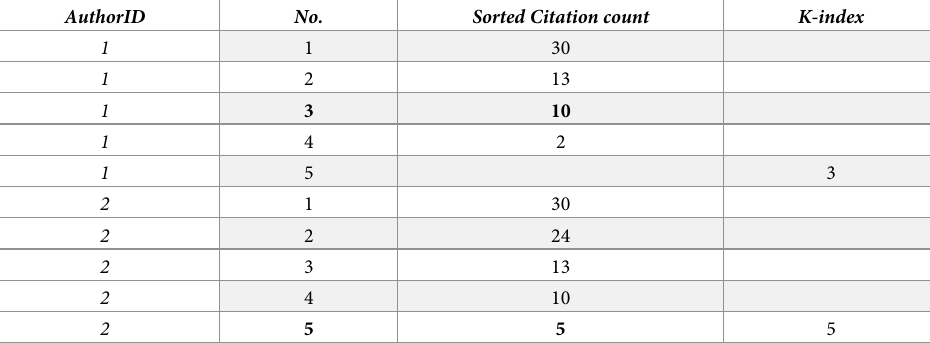
Table 6. Calculation of